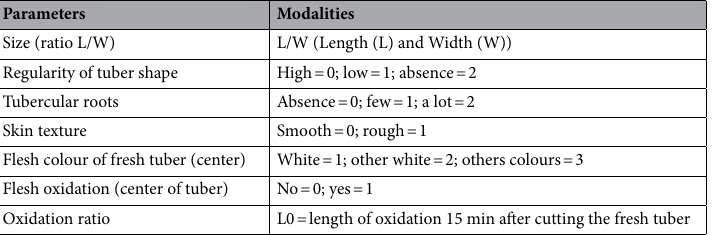
Table 1. List of parameters measured on populations A and B and parents during the years 2018 and